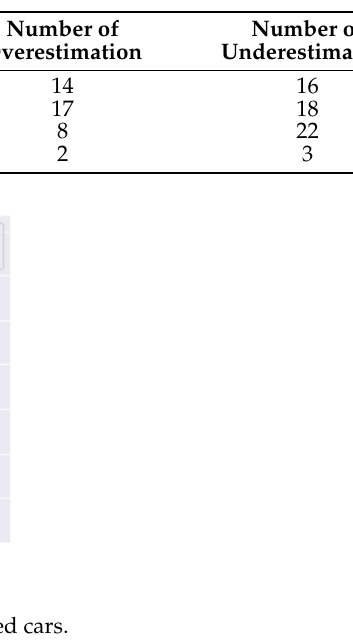
Table 8. Overestimation and underestimation of the predicted price.